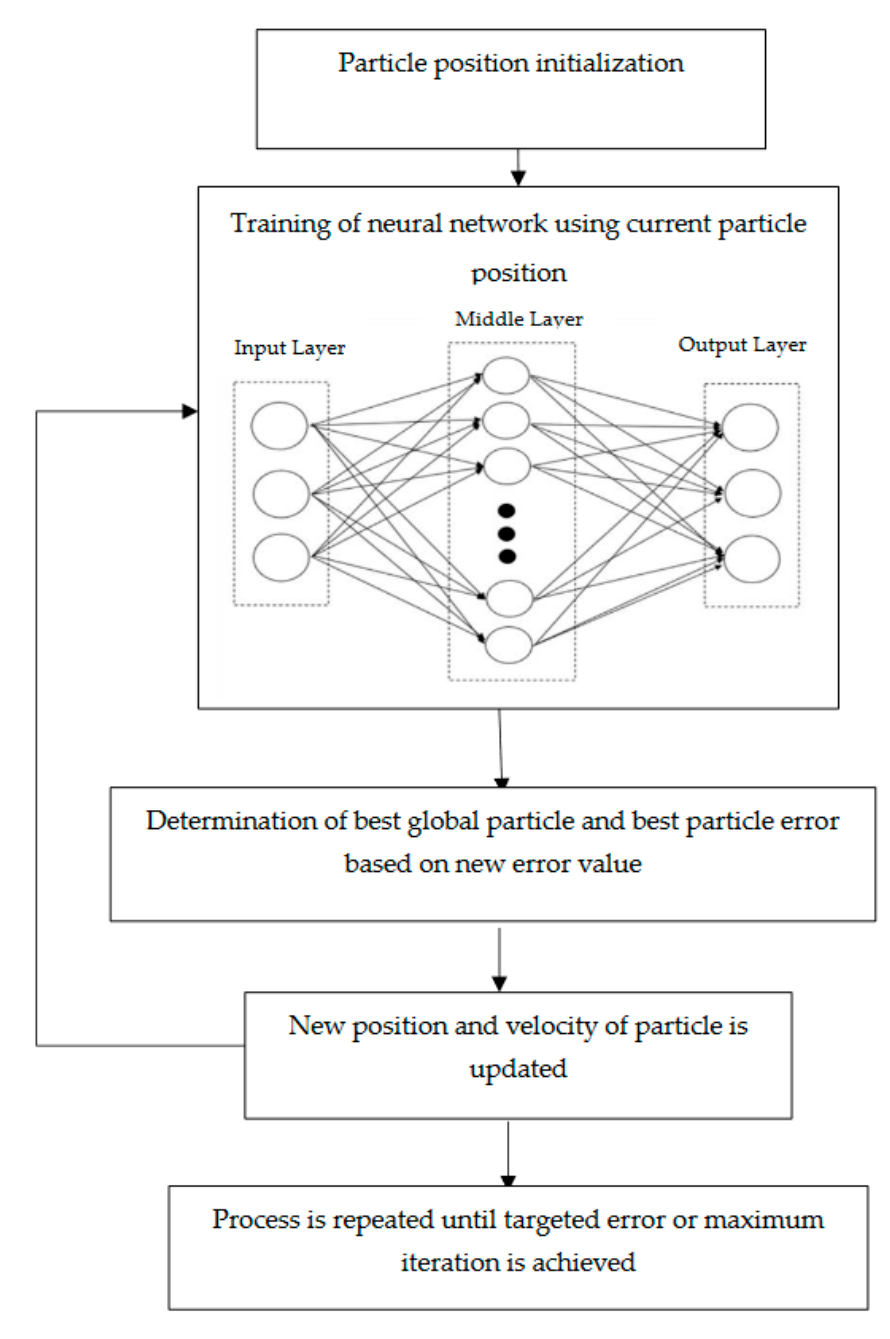
Figure 3. PSO learning algorithm in ANN development.